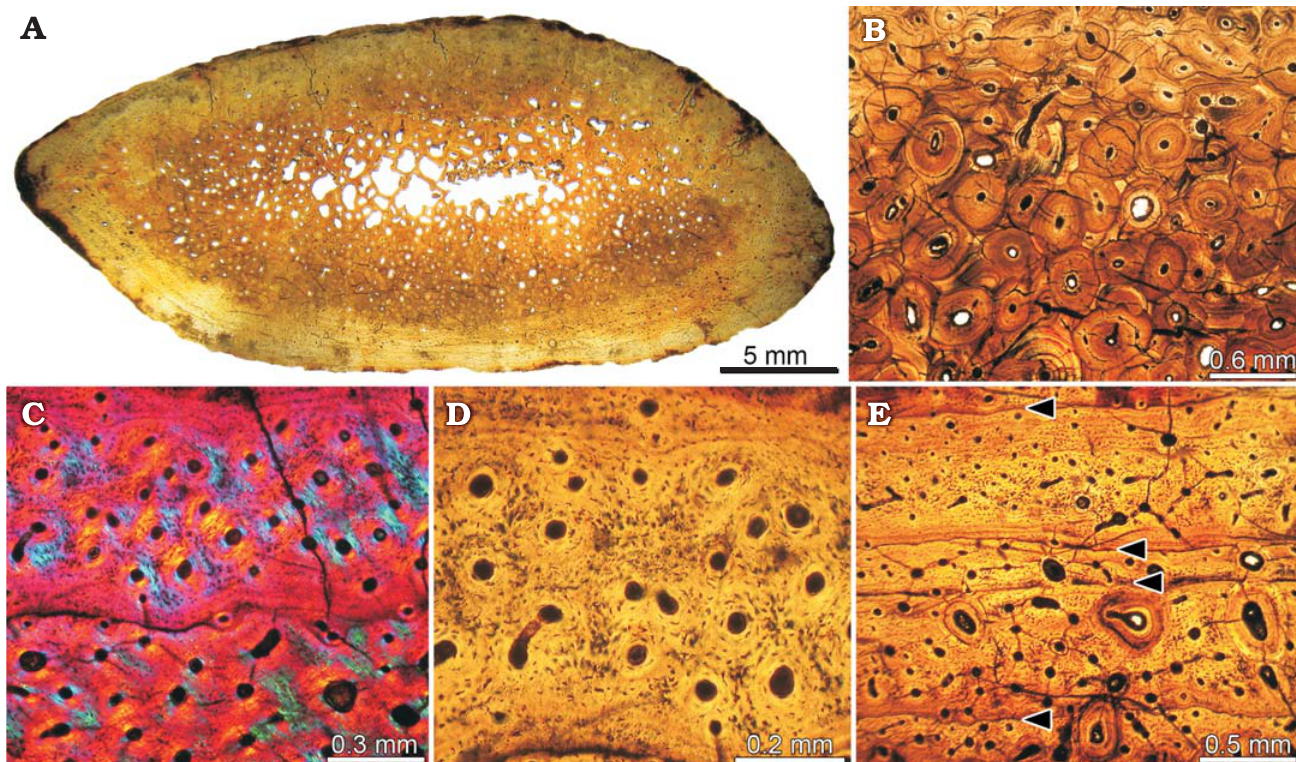
Fig. 6. Histology of a dorsal rib (UNPSJB-PV 1007/28) of the holotype of the rebbachisaurid sauropod Katepensaurus goicoecheai Ibiricu, Casal, Martínez, Lamanna, Luna, and Salgado, 2013a from the Cenomanian–Turonian Bajo Barreal Formation of Chubut Province, Argentina. A . Complete cross section of the rib sampled for histology. B . Detail of the dense Haversian bone in the cortex. C . General view of fibrolamellar bone tissue. D . Detail of fibrolamellar bone tissue. Note the abundance of longitudinally oriented vascular spaces in C and D. E . Four of the seven growth marks preserved in the primary bone tissue (indicated by